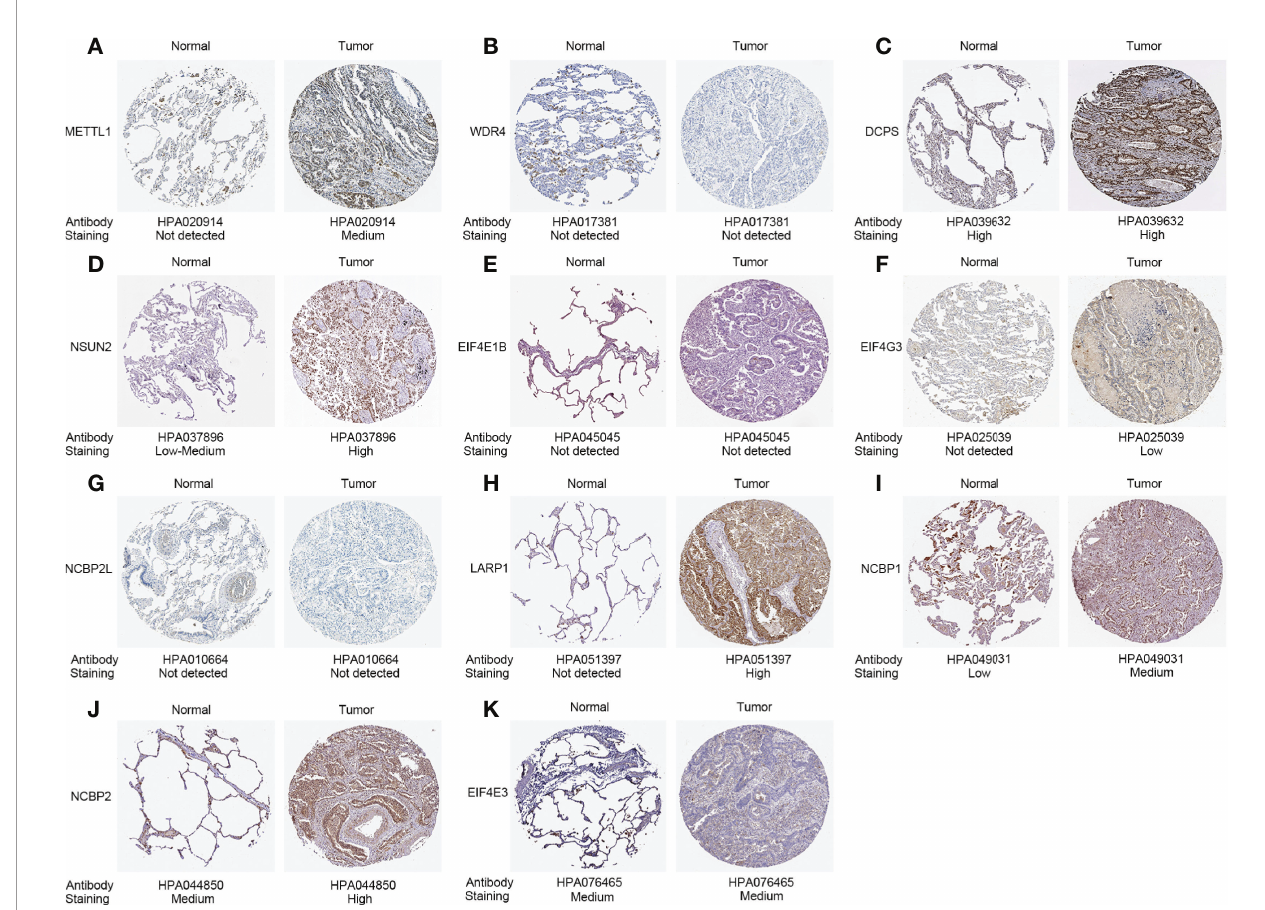
FIGURE 2 | Protein expressions of 11 differentially expressed m 7 G-related genes in the tumor and normal tissues from the Human Protein Atlas platform. (A) METTL1 expression. (B) WDR4 expression. (C) DCPS expression. (D) NSUN2 expression. (E) EIF4E1B expression. (F) EIF4G3 expression. (G) NCBP2L expression. (H) LARP1 expression. (I) NCBP1 expression. (J) NCBP2 expression. (K) EIF4E3